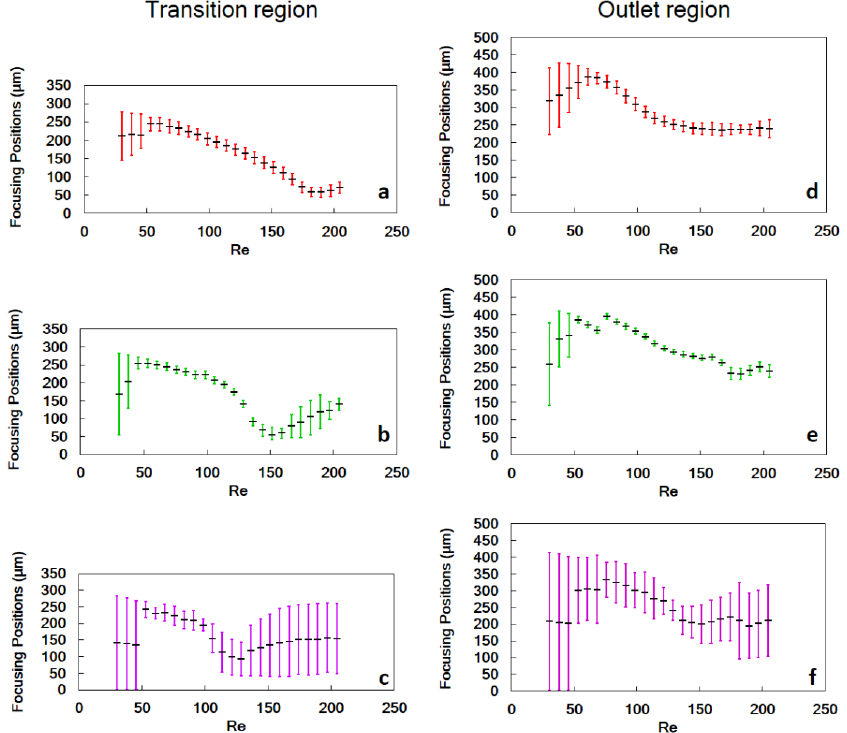
Figure 2. Focusing position against the Reynolds numbers ( Re ) at the transition region for the particles of ( a ) 20 µm, ( b ) 15 µm, and ( c ) 10 µm diameter as well as at the outlet region for the particles of ( d ) 20 µm, ( e ) 15 µm, and ( f ) 10 µm diameter. The width of the focusing bands is shown by error bars. The focal positions of 0 and 350 µm in ( a – c ) correspond to walls W 2 and W 1 , and 0 and 500 µm in ( d – f ) represent inner and outer walls, respectively.